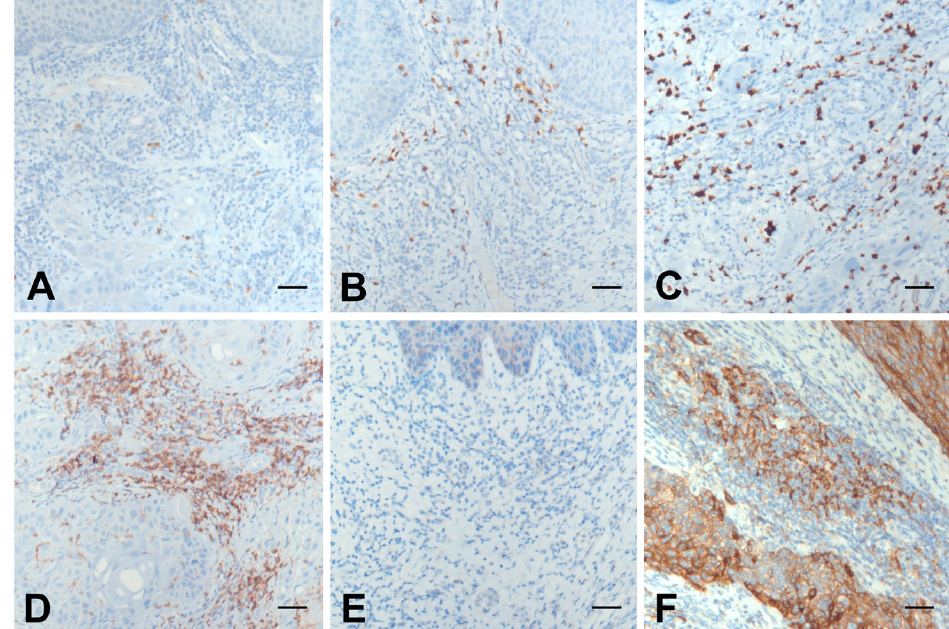
Figure 3. Representative images of immunohistochemical stains scored as 0 (( A ); CD57, larynx SCC), 1 (( B ); CD8, tongue preinvasive lesion), 2 (( C ); CD15, tongue SCC) and 3 (( D ); CD4, larynx SCC) and of PD-L1 ( E , F ), graded as low (0, < 1, ( E ), larynx preinvasive lesion) and high (1, ≥ 1, ( F ), tongue SCC). Bars: 100 µm.